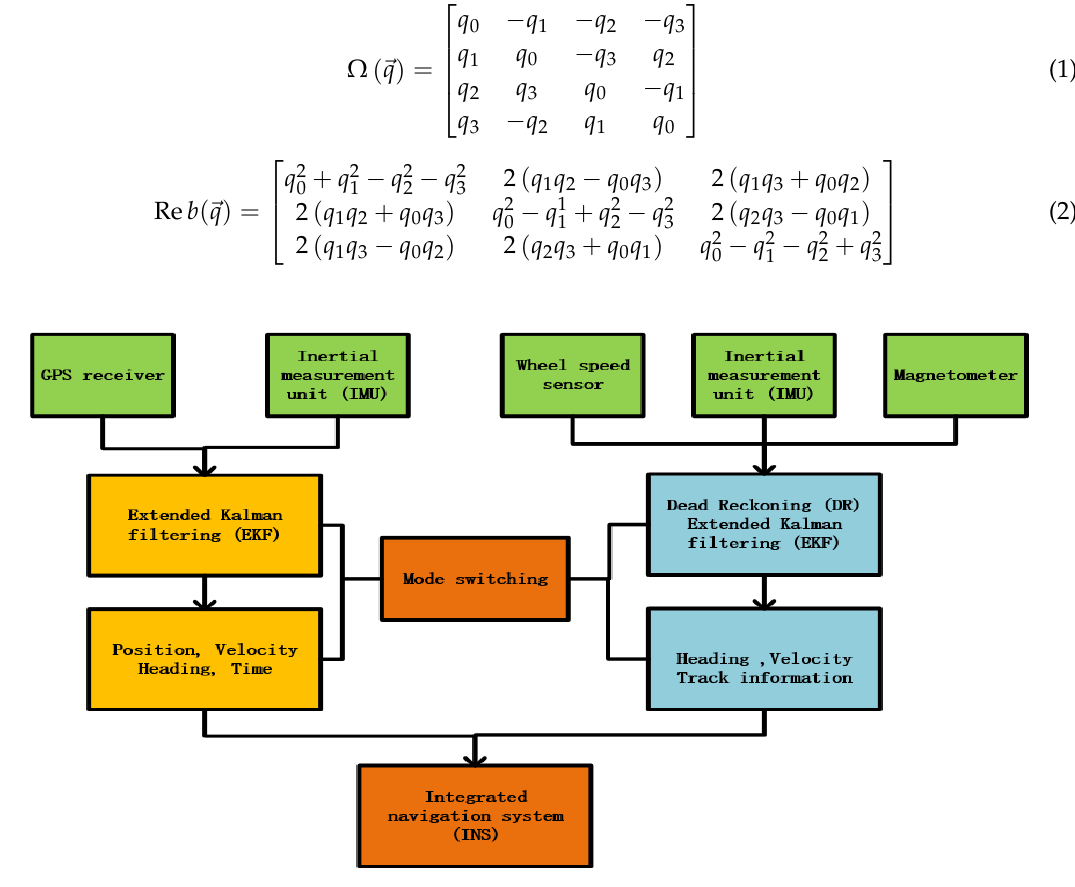
Figure 1. System algorithm structure